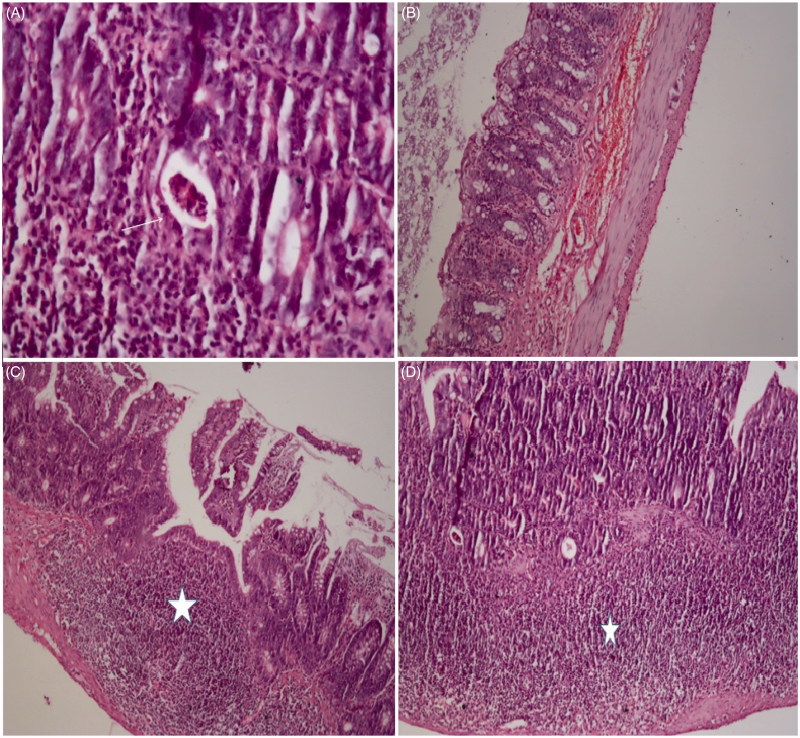
Intestine, radiation-induced histopathological changes. Histopathology is shown under the light microscope of the intestine using haematoxylin–eosin (H&E) in the rats that received RT. (A) Crypt abscess (arrow) in the small intestine, H&E ×200. (B) Congestion in the colon wall, H&E ×100. (C) Intensive lymphoid infiltration (star) in the small intestine H&E ×100. (D) Dense inflammation (star) in the small intestine, H&E ×100.